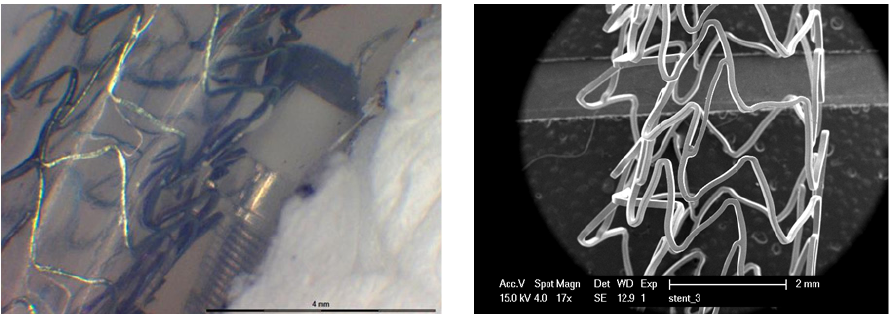
Figure 6: The head of the electrode during extraction (left) and the deformed stent after the procedure (right). 3.5/10 mm stent